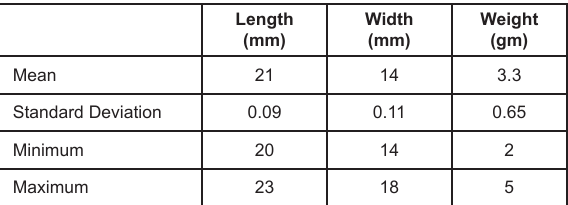
Table 2. Length, width and weight variations in the eggs of Small Bee-eater (N = 56)